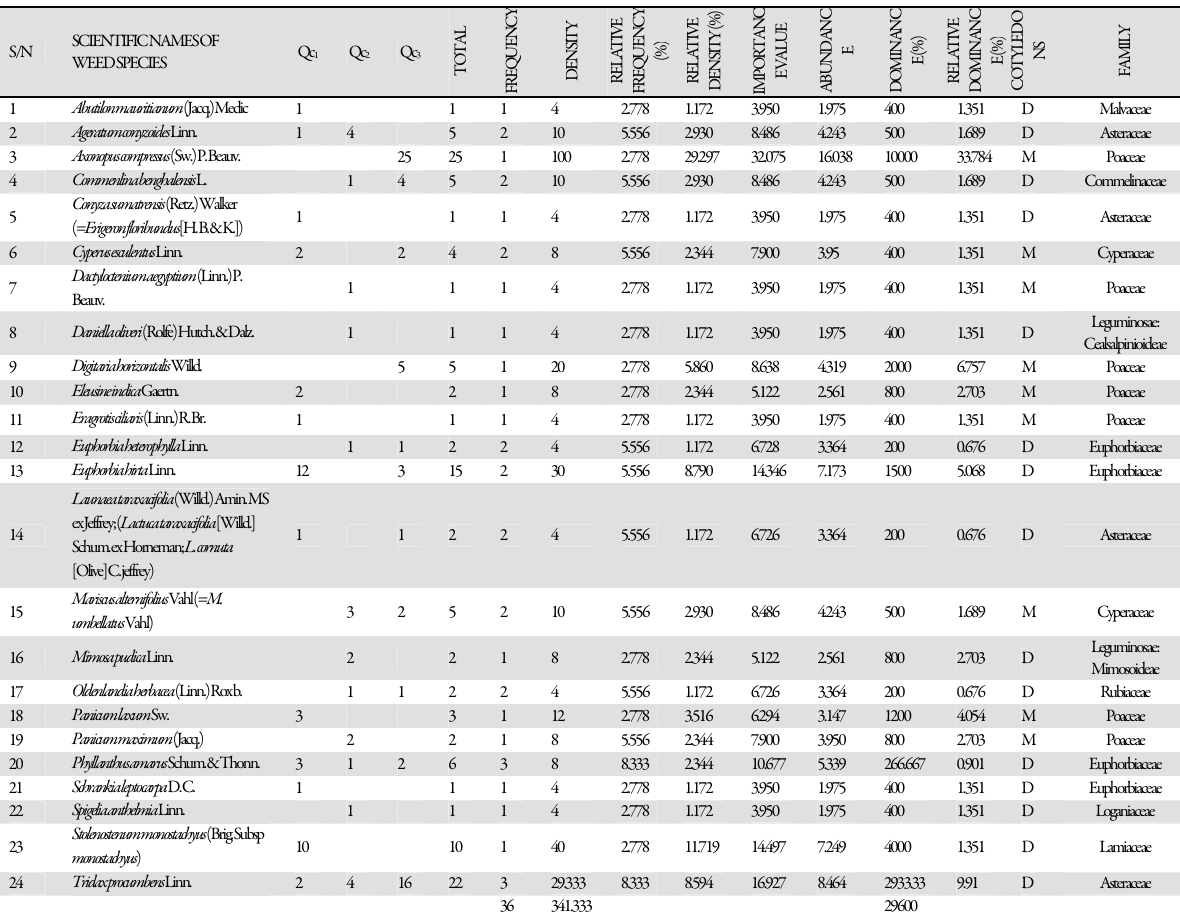
Tab. 7. Weed flora and species parameter for control plot at 3WAP SCIENTIFIC NAMES OF S/N WEED SPECIES